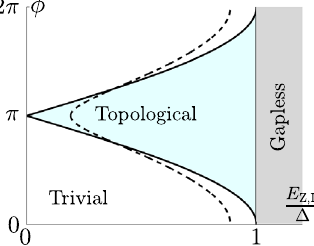
FIG. 4. Phase diagram as a function of the Zeeman field in the leads E and the phase difference ϕ in the limit of a narrow Z;L ≪ E > Δ , the system becomes junction with E . For E Z;J T Z;L gapless. The solid lines are the phase boundaries in the absence of any normal backscattering, while the dashed lines correspond to 3 π = 8 W þ φ junction transparency of 0.75 and a phase k FIG. 3. (a – c) Numerical results for the phase diagram as a F N ¼ function of the Zeeman field and the chemical potential for different values of ϕ , obtained using the scattering matrix approach (see Appendix D 1 for details). The width of the junction is W ¼ 5 ð m Δ Þ − 1 = 2 . The phase boundaries are deter- 0 . At low chemical potentials, mined by a gap closing at k x ¼ μ ≃ Δ , a finite amount of normal reflection from the super- conducting leads results in oscillatory modulations of the phase boundaries as a function of μ . The topological phase significantly expands as the phase difference between the leads is tuned from 0 to π . (d) Same as (c) but with a rectangular potential barrier at each interface between lead and junction. The barrier has height 200 Δ and width 0 . 01 ð m Δ Þ − 1 = 2 . This corresponds to a trans- parency of 0.82 at μ ¼ 10 Δ . The presence of a reflecting barrier leads to stronger modulations of the boundaries.